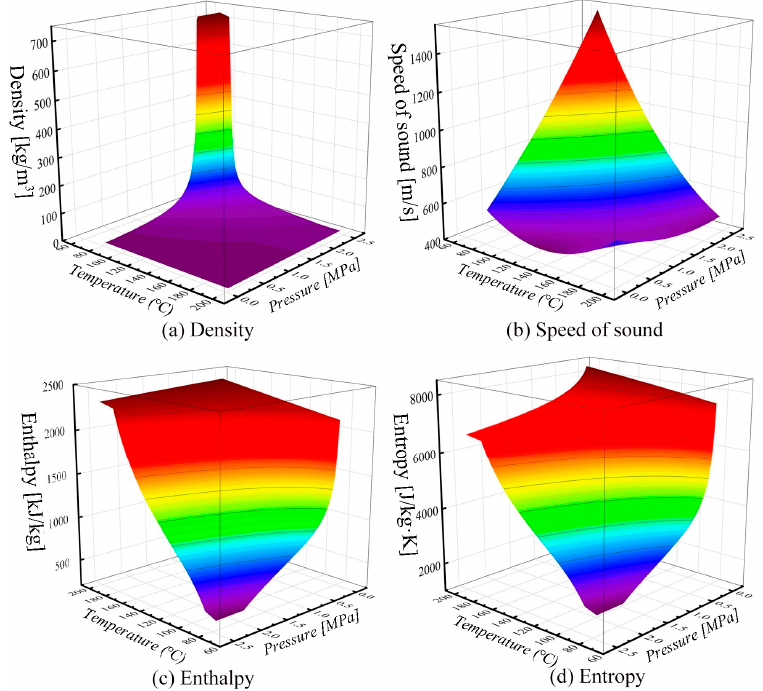
Figure 4. Physical property of ammonia-water mixture (ammonia mass fraction = 0.58).